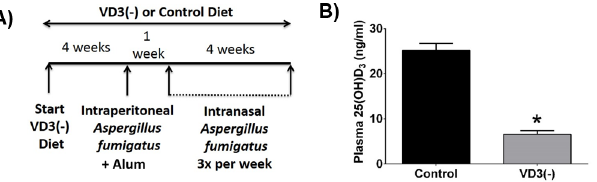
Fig 1. Model summaryand plasma 25(OH)D 3 levels. ( A) Schematicof the vitamin D deficient Af-CRS protocol. B) Confirmation of 25(OH)D 3 deficiencyafter 4 weeks on VD3 deficientdiet. n = 4 control, 6 vitamin D3 deficient [VD3(-)] mice per group. * p < 0.05 vs